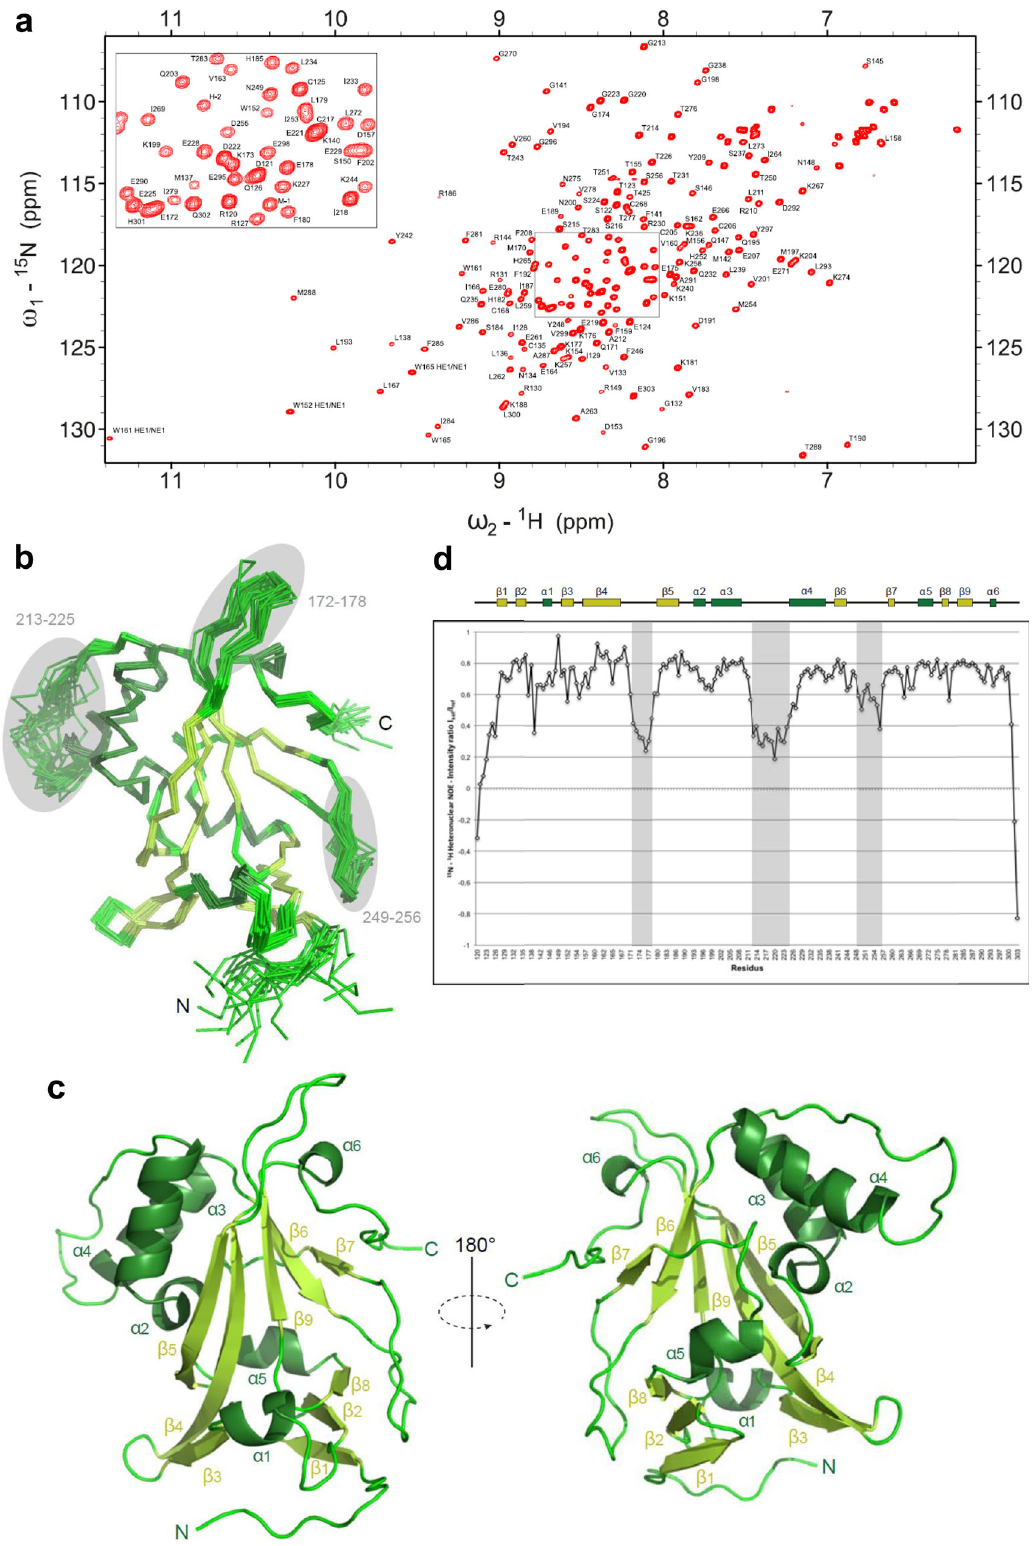
Fig. 5 Solution 3D structure of Bcd1p 120-303 . a 1 H- 15 N-HSQC spectra of Bcd1p 120-303 . The assigned peaks are labeled ( ω = frequency). The box shows a zoom of the center of the spectra. b Ribbon representation of the 20 best NMR solutions for the 3D structure of Bcd1p 120-303 . Flexible loops are circled in gray and labelled. Secondary structure elements are α -helices (in dark green) and β -strands (in light green). N and C are the N-terminal and C-terminal extremities of the protein, respectively. c Two opposite views 180° apart in a cartoon representation of Bcd1p 120-303 with secondary structures labeled and numbered. The color code is the same as in panel b . d NMR heteronuclear nOe. Residue numbers are indicated at the bottom. Secondary structure elements are represented at the top in the same colors as in panel b . The fl exible internal regions are highlighted in gray, and reported in panel b